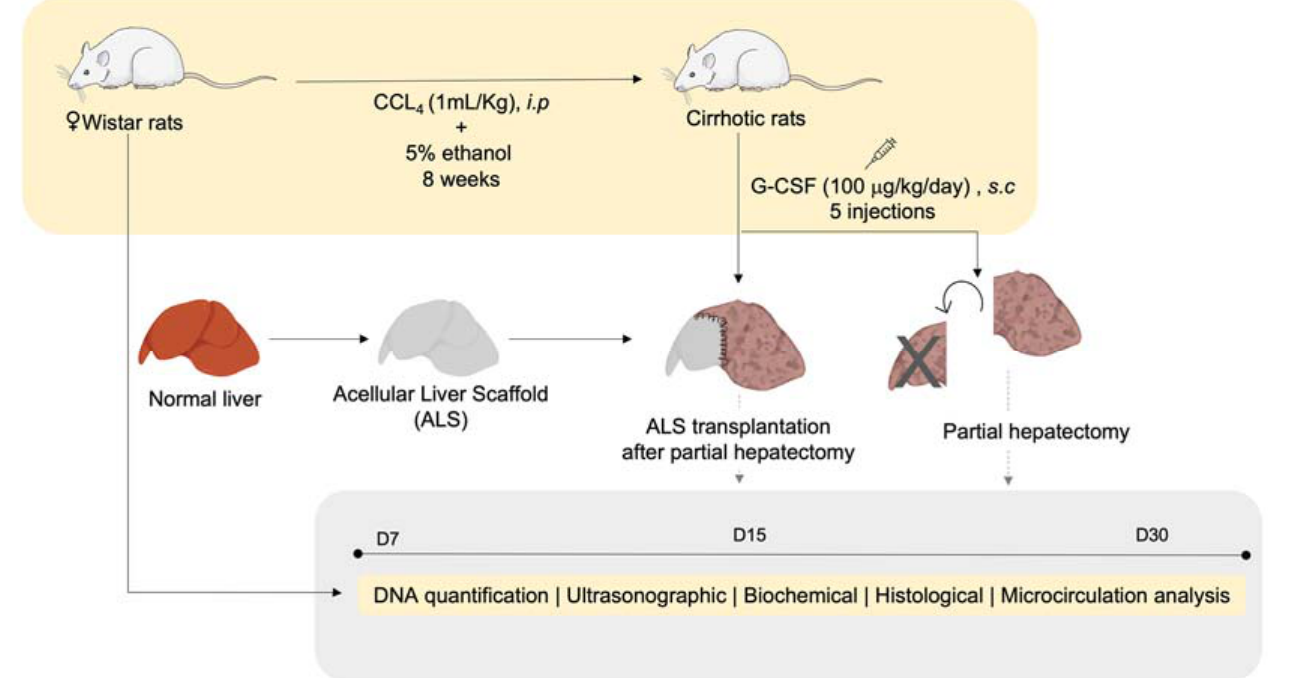
Figure 1. Experimental design. The animals were subjected to liver cirrhosis induction by intraperi- toneal injections of carbon tetrachloride (CCl 4 ) in association with 5% ethanol in drinking water. At the same time, the donor animals underwent surgical excision of the liver. The livers were decellu- larized to generate an acellular liver scaffold (ALS). Five consecutive days before transplantation, the recipient animals (cirrhotic animals) received subcutaneous injections of granulocyte colony- stimulating factor (G-CSF). The ALS was then transplanted, and ultrasonographic, microcirculation, biochemical, and histological analyses were performed 7, 15, and 30 days after